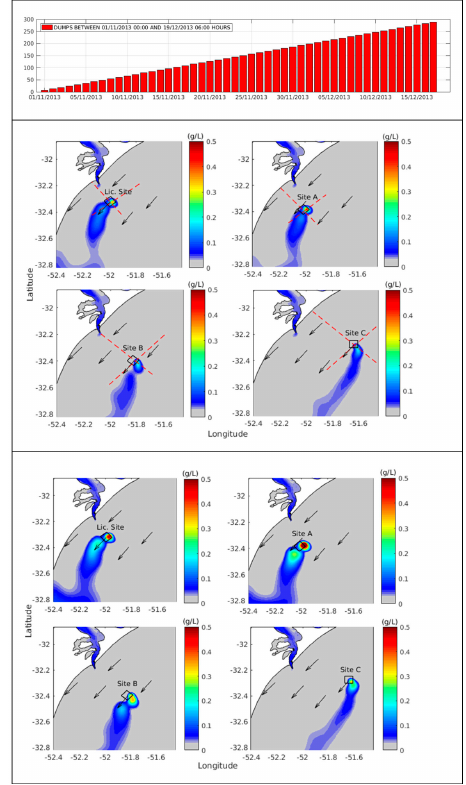
Figure 9. Top panel—Accumulated number of discharges on 19 December 2013 at 00:00 h. Dispersion plume at the surface (central panel) and at the bottom (bottom panel) after 292 discharges on the Licensed and alternative disposal Sites A, B, and C. Color scale indicates suspended sediment concentrations (g/L), where gray indicates concentrations lower than 0.025 g/L and red indicates concentrations varying from 0.5–8 g/L. Red dotted line indicates the position of the longitudinal and transversal profiles for which results were extracted. Black arrows indicate the wind direction from the SW. Wind velocity during this event was 9.8 m/s.